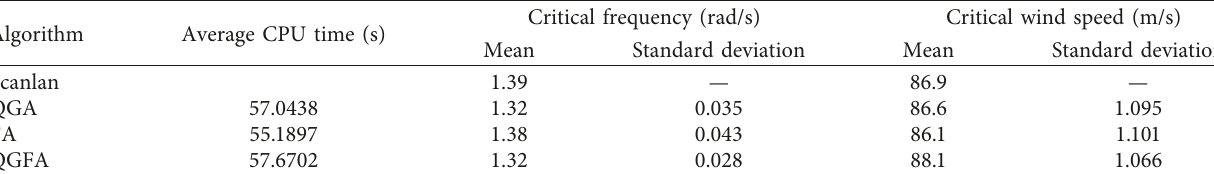
Figure 5: Flutter derivatives in Case II. Table 4: Comparison of computational results (Case II).